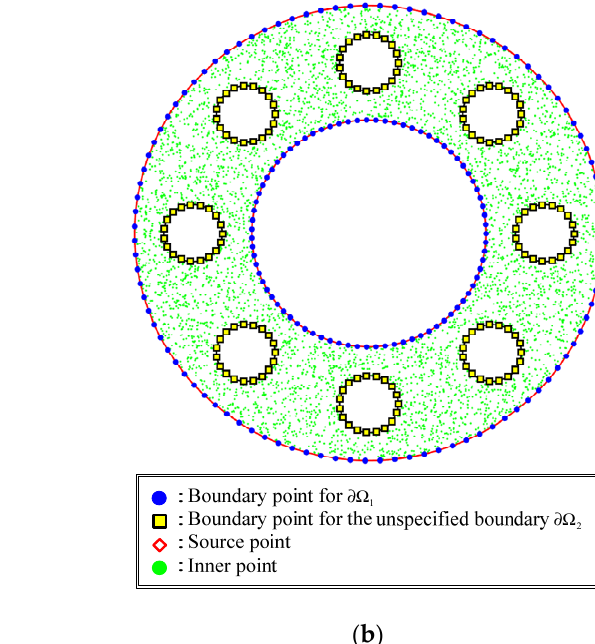
u Figure 11. Comparison of solution along the hole boundary with 0.03 =δ